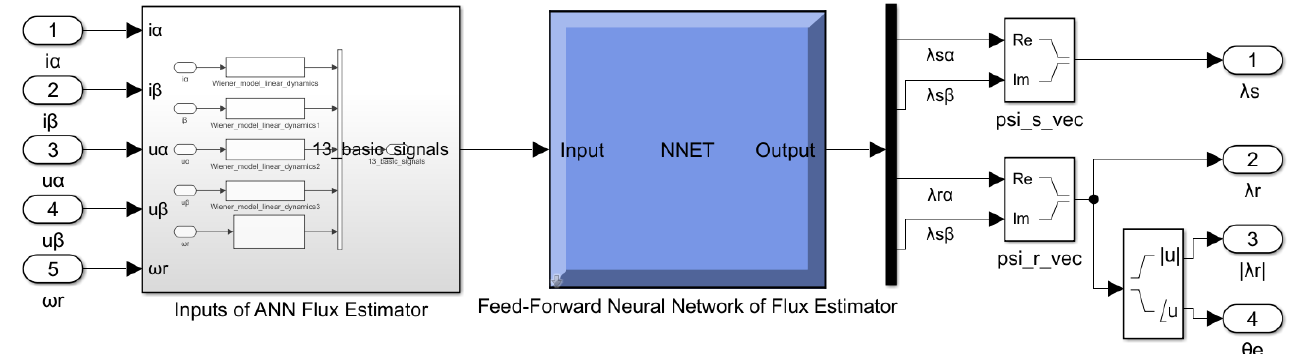
Figure 9. The feed-forward neural network of flux estimator.